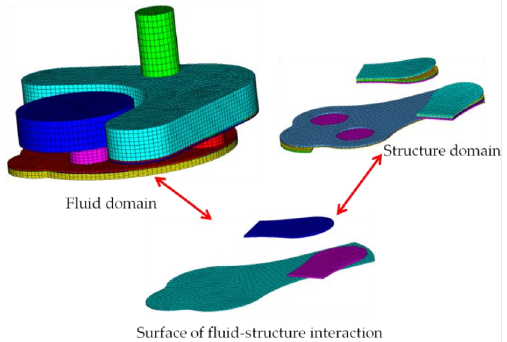
Figure 5. The complete 3D fluid–structure interaction model of the reciprocating